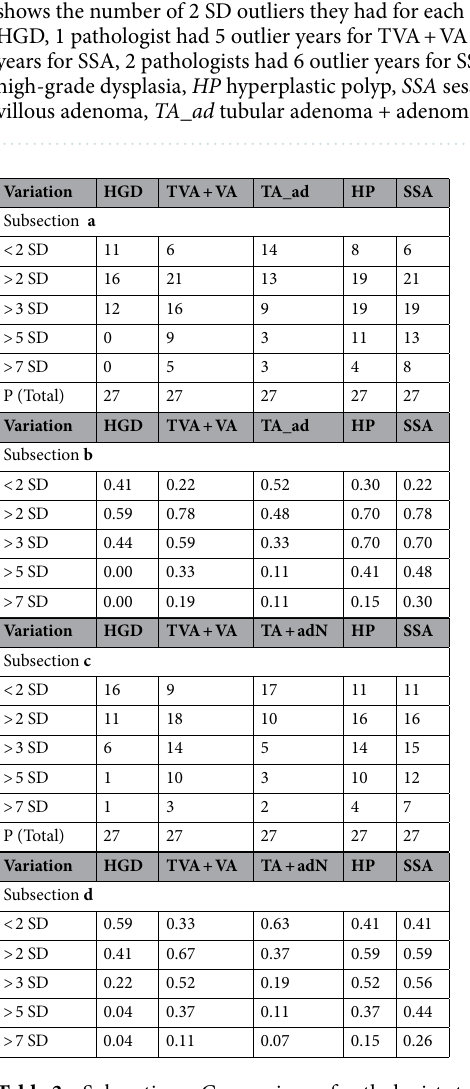
Table 3. Subsection a Comparison of pathologists to the 27 pathologists that read > 600 CRPS. Number of outlier pathologists based on the group median diagnostic rate. The number of “ < 2 SD” and “ > 2